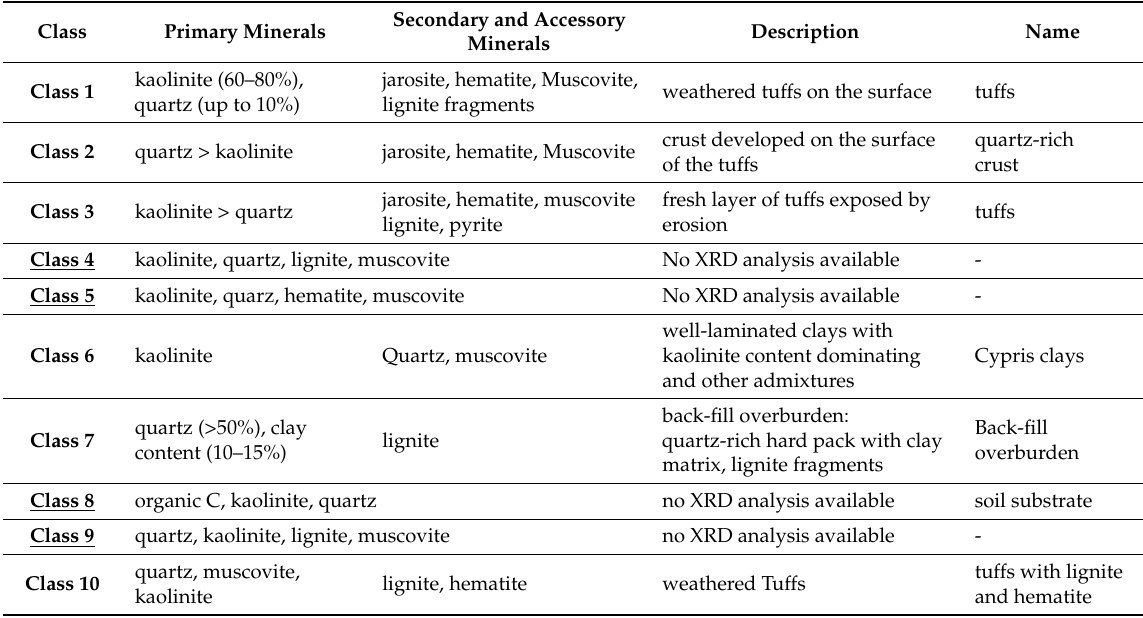
Table 1. Map classes from Figures 7–10 compared to the XRD analysis and field documentation of the samples that fall spatially within each class. For Classes 4, 5, 8 and 9 there were no XRD analyses available; however, the mineral description based on the interpretation of the spectral property was